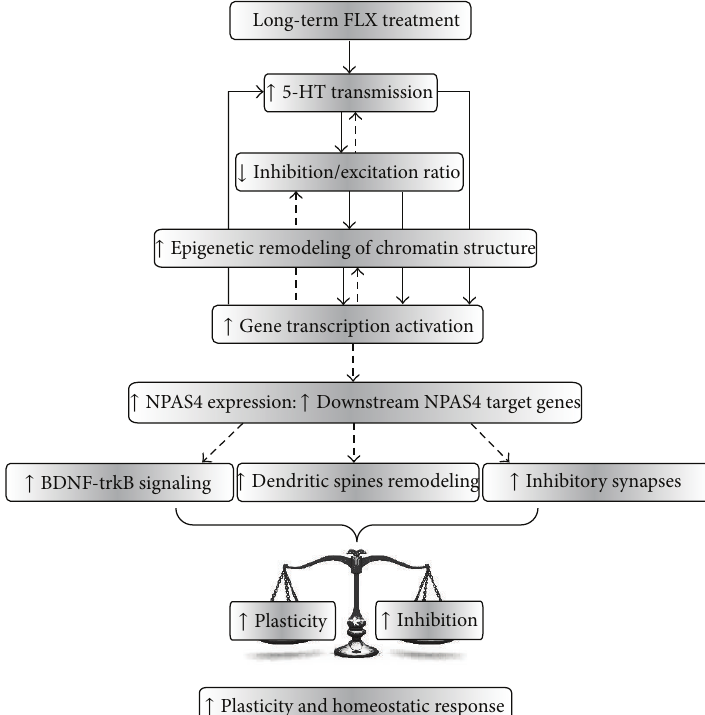
Figure 2: The process of plasticity reactivation in the adult visual system. The reinstatement of plasticity caused by FLX in adult life is associated with signal transduction pathways that involve the activation of long-distance serotonergic transmission, a downregulation of local intracortical inhibitory circuitries and enhanced NPAS4 expression. The experimental evidence is consistent with a model in which the increased serotonergic signaling shifts the inhibitory/excitatory balance, thus activating intracellular mechanisms that eventually promote epigenetic modifications of chromatin structure that, in turn, allow for the expression of plasticity genes in adult life, among which NPAS4 plays a key role. NPAS4 seems to turn on a transcriptional program that underlies structural and functional plasticity while facilitating, in parallel or in series, a reorganization of inhibitory circuitries that might contribute to the homeostasis of cortical excitability by driving inhibition during this phase of enhanced plasticity. The transitory expression of NPAS4 target genes may ultimately set in motion downstream physiological mechanisms that provide a permissive environment for changes in adult visual cortical circuitries (e.g., enhanced Bdnf- trkB signaling, removal of extracellular matrix components that are inhibitory for plasticity, and enhanced dendritic spines density and remodeling). Continuous arrows represent established interactions between molecular and cellular processes mentioned (boxes). Dashed lines represent interactions that remain to be ascertained. Reproduced from [101] with